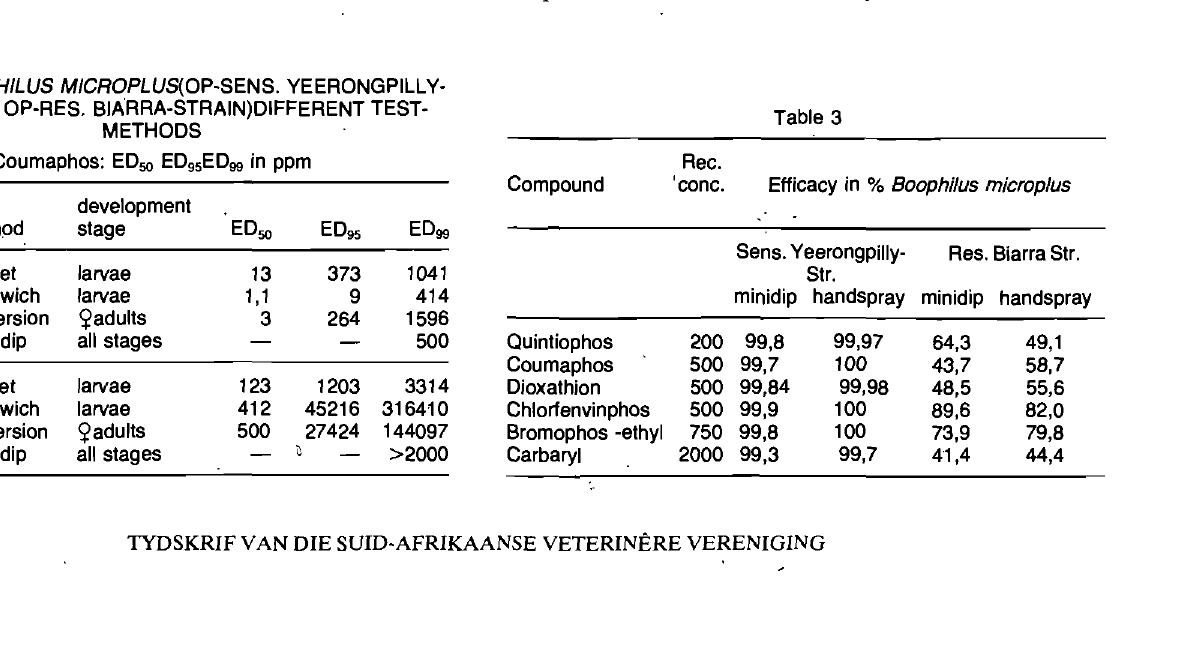
Table 2: BOOPHILUS MICROPLUS(OP-SENS. YEERONGPILL Y- STRAIN AND OP-RES. BIA'RRA-STRAIN)DIFFERENT TEST- METHODS